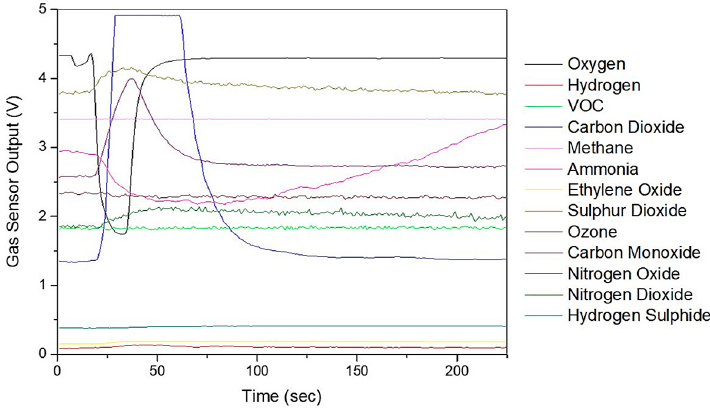
Figure 2. Wolf eNose and custom Bio-VOC injection system.